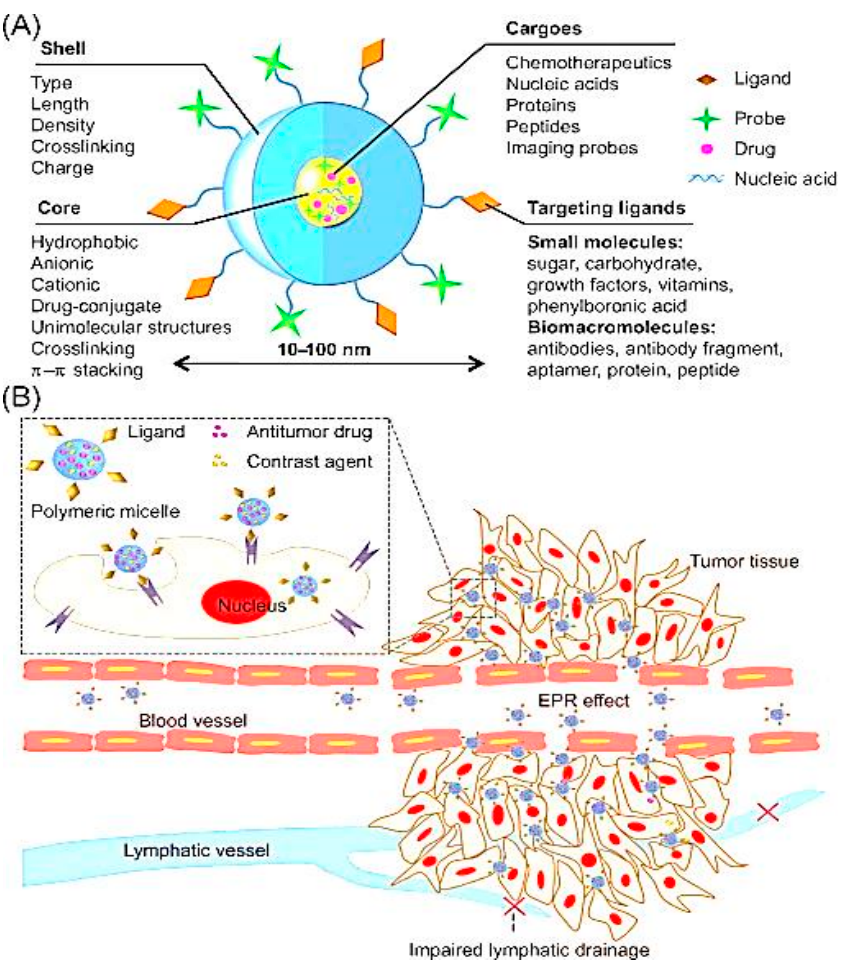
Figure 4. Polymeric micelles for cancer theranostics. ( A ) The composition of polymeric micelles. ( B ) Polymeric micelles target tumor tissues for cancer theranostics, and can be specifically accumulated in tumor tissues through the EPR effect for cancer diagnosis and therapy. EPR: Enhanced permeability and retention. Reproduced from [273] with permission from Elsevier, 2019.